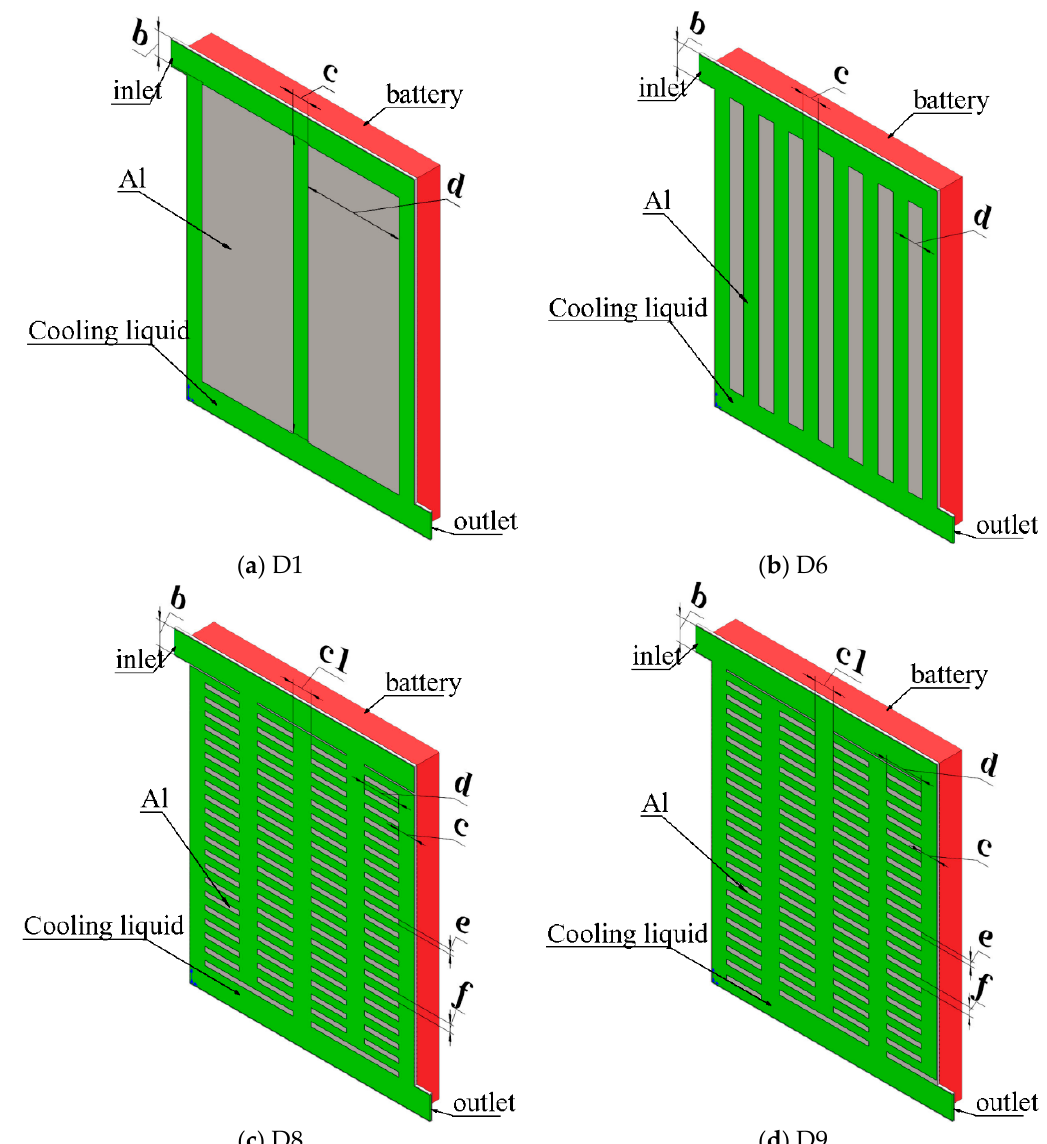
Figure 2. The diagrams showing the geometry of the simulated cold plate. ( a ) Z-type parallel channel design with 3-branches (D1); ( b ) Z-type parallel channel design with 8-branches (D6); ( c ) cross-linked channel design (D8); ( d ) cross-linked channel design with improved topology (D9). The characteristic dimensions associated with each design are marked by geometric parameters a , b , c , c1 , d , e , and f in each